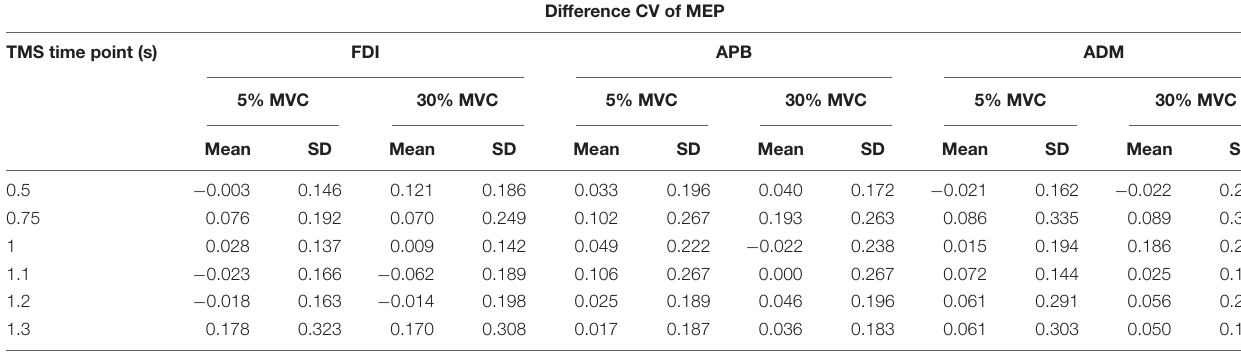
Difference CV of